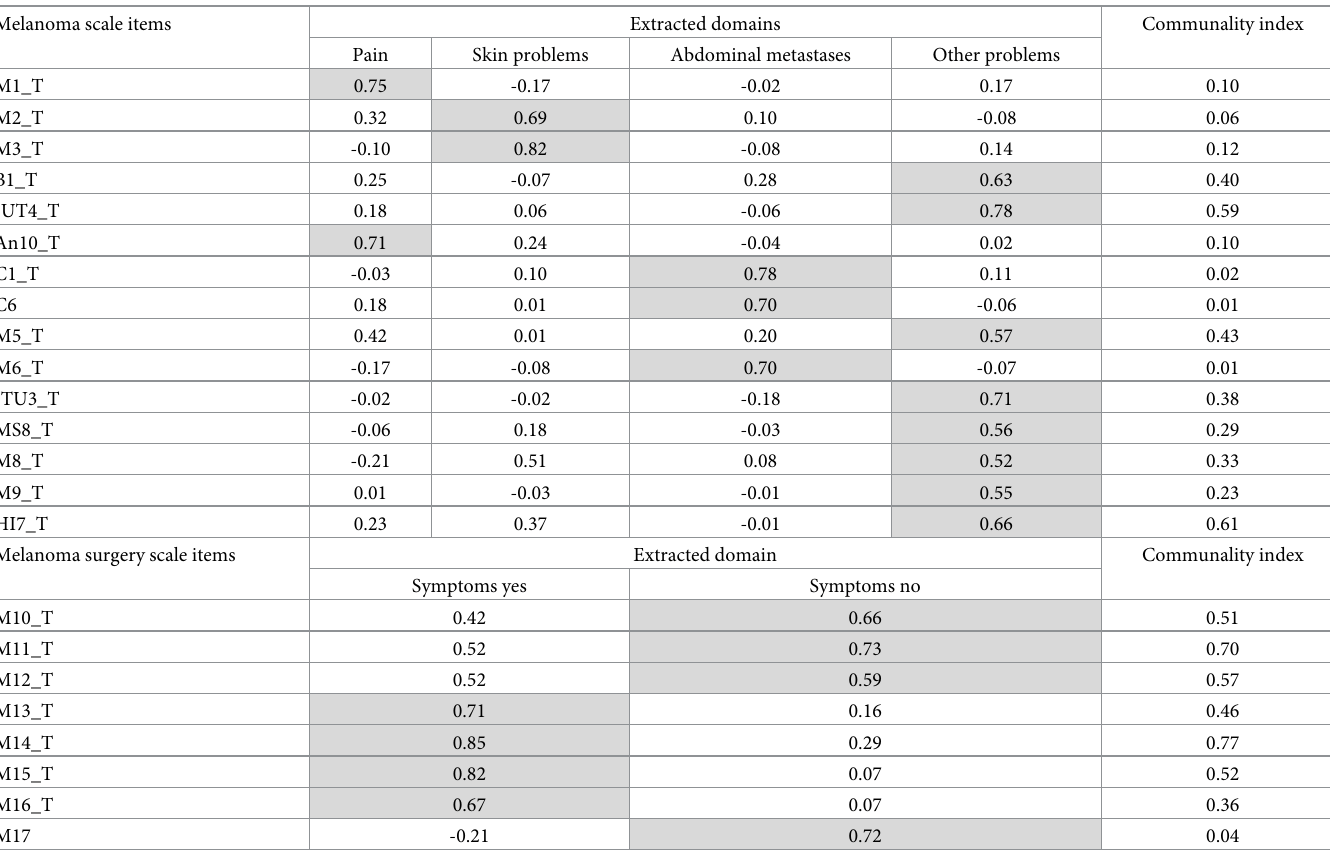
Table 4. Correlation coefficients of the Melanoma scale and Melanoma surgery scale items of the FACT-M and factors extracted after Varimax rotations in EFA.